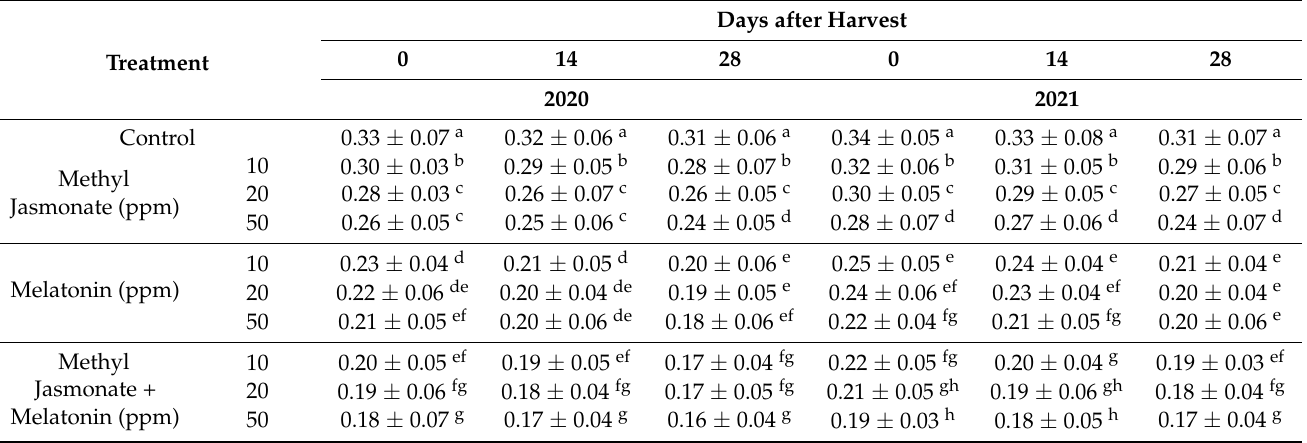
Table 7. Effects of foliar application of melatonin and/or methyl jasmonate solutions at different concentrations on the total acidity (g citric acid/100 mL juice) in date palm fruits (cv. Barhi) stored at 4 ◦ C for 28 days